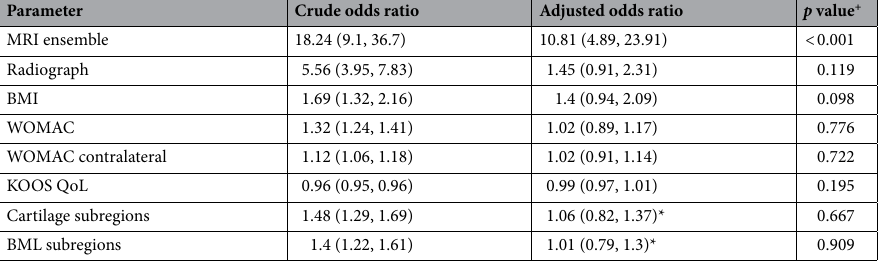
Tables 3 and 4 shows the AUCs and AUPRCs of the models developed to predict TKR evaluated using the internal hold-out testing group in the OAI database and the external testing group in the MOST database, respec- tively for all knees combined. All models showed a small decrease in diagnostic performance for the internal testing group with AUCs between 0.84 and 0.89 compared to AUCs between 0.85 and 0.90 for the sevenfold nested cross-validation. All models showed a larger decrease in diagnostic performance for the external testing group with AUCs between 0.55 and 0.71. The DESS, FS-IW-TSE, and MRI ensemble models had the highest AUCs between 0.67 and 0.71 for evaluating the sagittal fat suppressed intermediate-weighted TSE images in the MOST database, while the FS-IW-TSE and MRI ensemble models had the highest AUCs of 0.69 and 0.66,